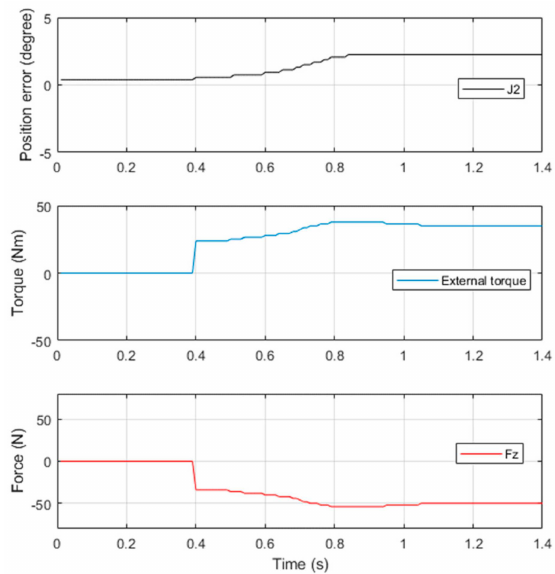
Figure 5. Calibration result of Joint 2 by 5 kg